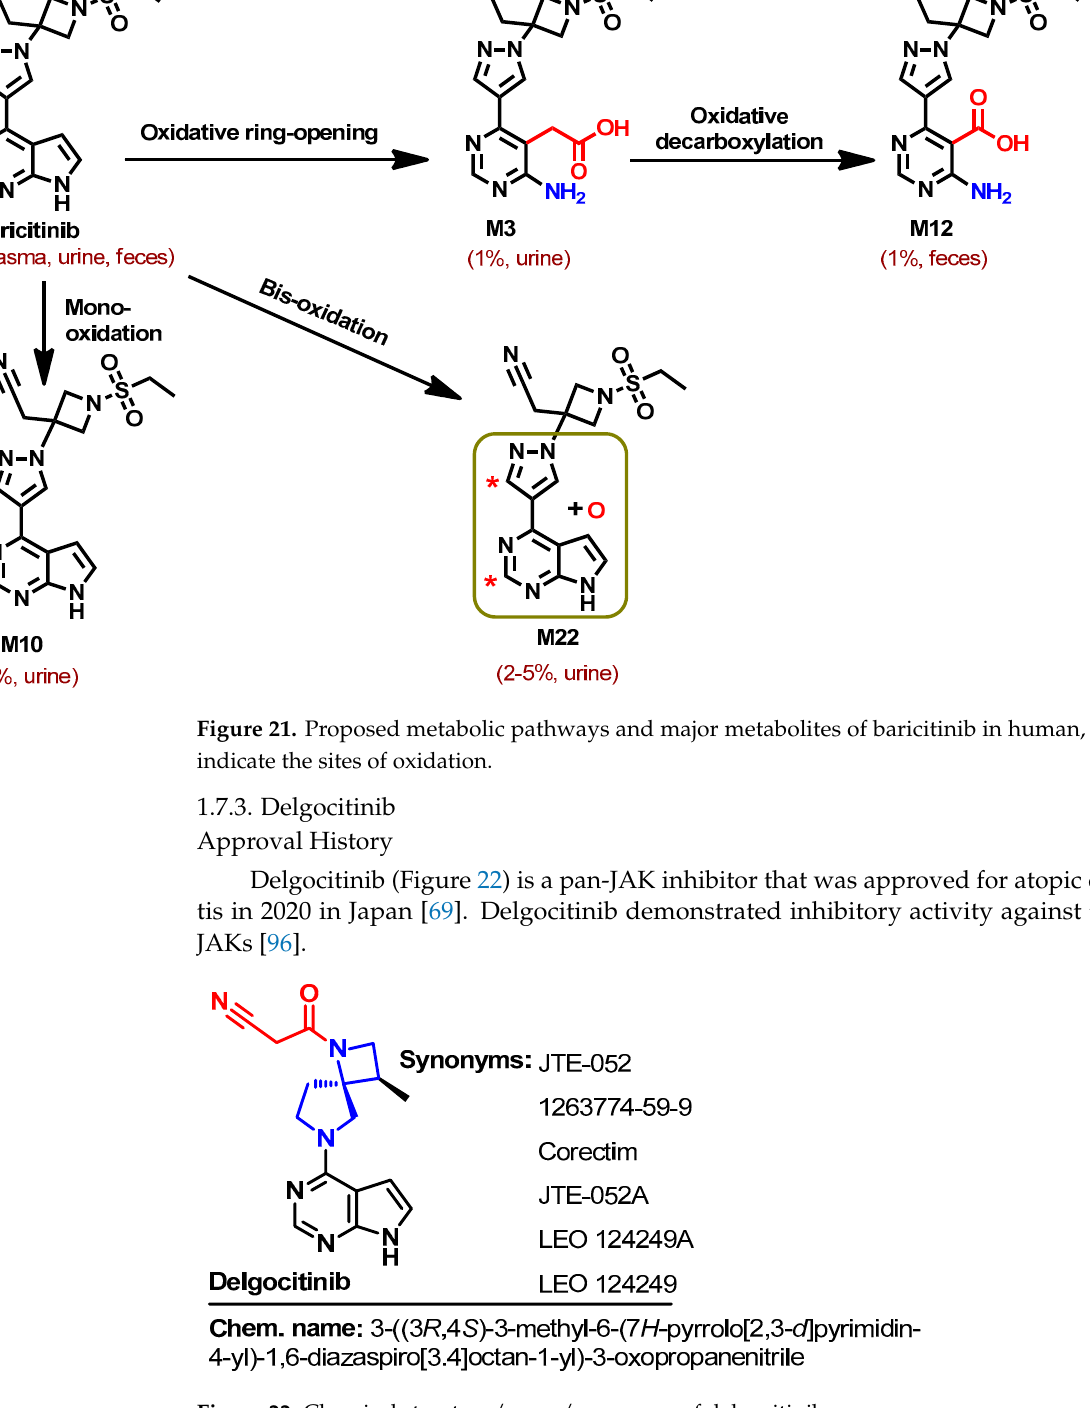
Figure 22. Chemical structure/name/synonyms of delgocitinib.